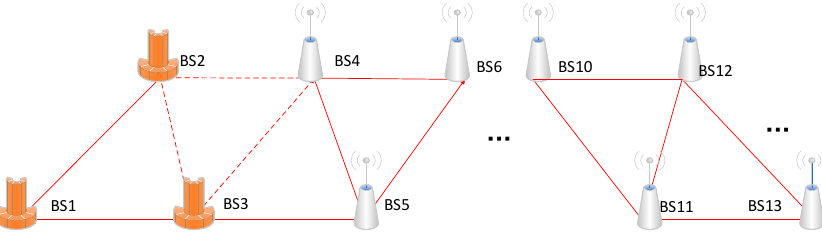
Figure 8. Coordinate transform to estimate virtual triangle unknown vertex. Electronics 2020 , 8 , x FOR PEER REVIEW